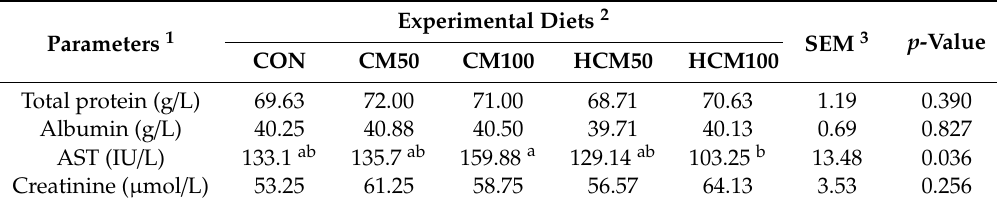
Table 5. Serum biochemical parameters of Meatmaster lambs that were fed untreated or heat-treated canola meal as a partial or complete replacement for soybean meal in finishing diets.